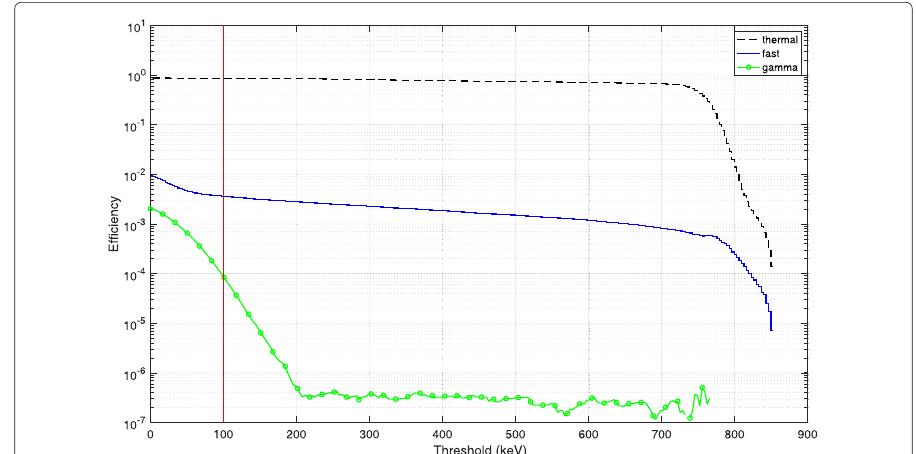
Fig. 13 Fast neutron sensitivity of the 3 He-detector as a function of the applied threshold. For a software threshold of 100 keV a fast neutron sensitivity on the order of 10 − 3 is